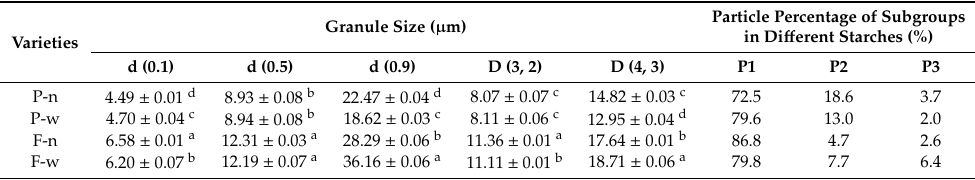
Data represent means ± standard deviations. For each column, values not displaying the same letter are significantly di ff erent ( p < 0.05). d (0.1), d (0.5) and d (0.9) are the granule sizes wherein 10%, 50%, and 90% of all the granules by volume are smaller, respectively. D (3, 2) is the surface area-weighted mean diameter. D (4, 3) is the volume-weighted mean diameter. P1, P2, and P3 are the particle percentage of subgroups in di ff erent starches obtained by flow cytometry